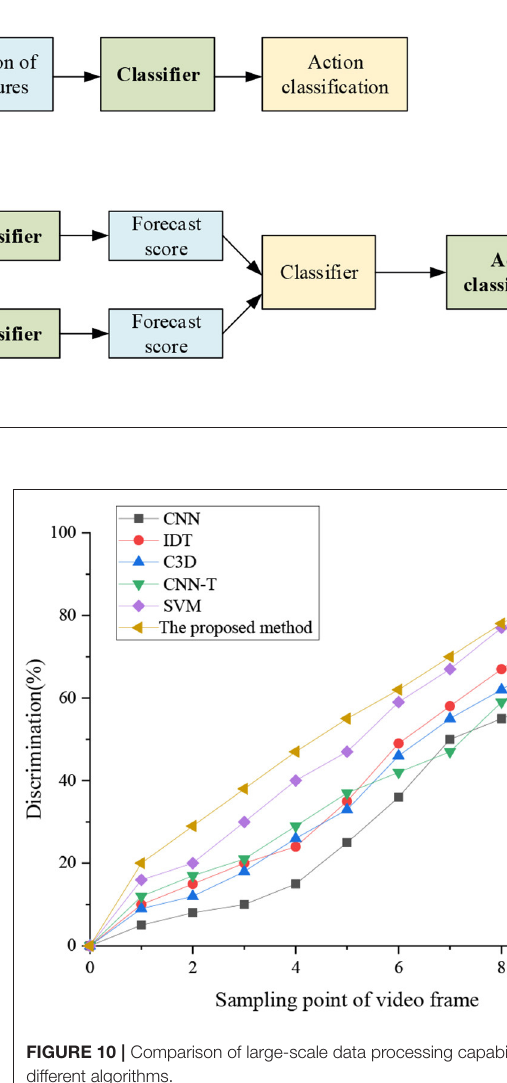
FIGURE 9 | MD of fuzzy MF.